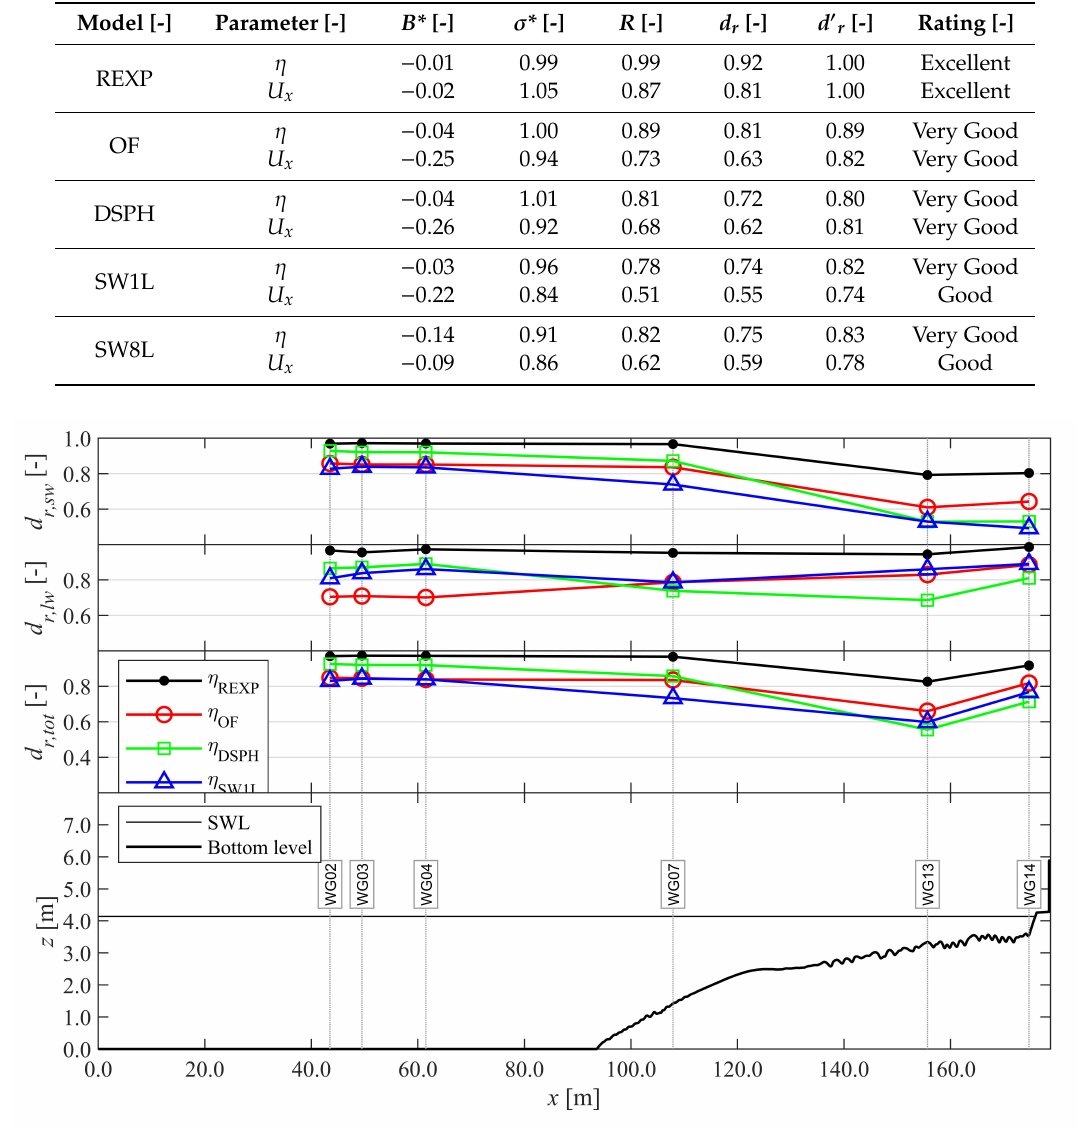
Figure 10. Comparison of d r , evaluated for REXP, OF, DSPH and SW1L with reference to EXP, up to the toe of the dike. From top to bottom: d r,sw for η SW , d r,lw for η LW , d r,tot for η , and finally an overview of the sensor locations, SWL, and bottom profile. Adapted from the work in [3], with permission from the authors,